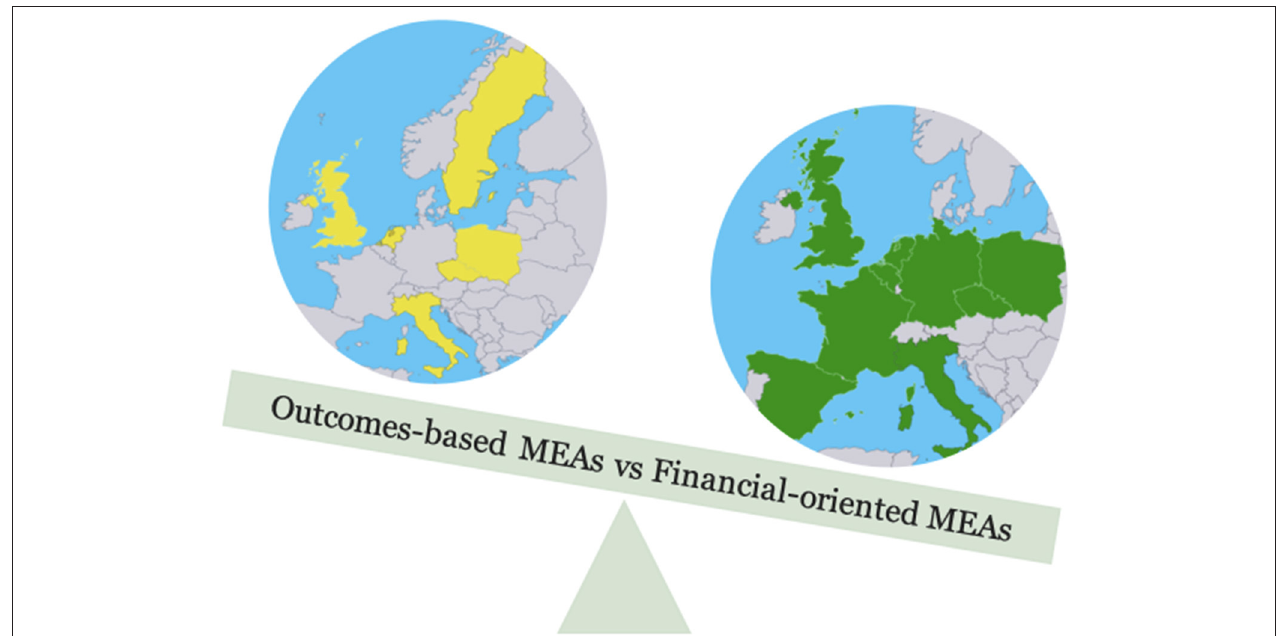
FIGURE 1 | Type of managed entry agreements across countries. MEA, managed entry